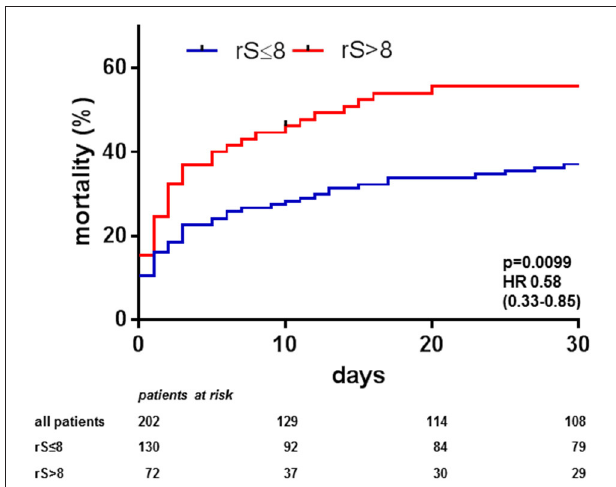
FIGURE 1 | Central illustration. Thirty-day mortality in acute myocardial infarction cardiogenic shock (AMI-CS) on Impella depending on completeness of revascularisation: Observed 30-days mortality in AMI-CS treated with Impella was lower if complete revascularisation defined by an residual Syntax score ≤ 8 was achieved by percutaneous coronary intervention (PCI) compared to less complete revascularisation (rS >